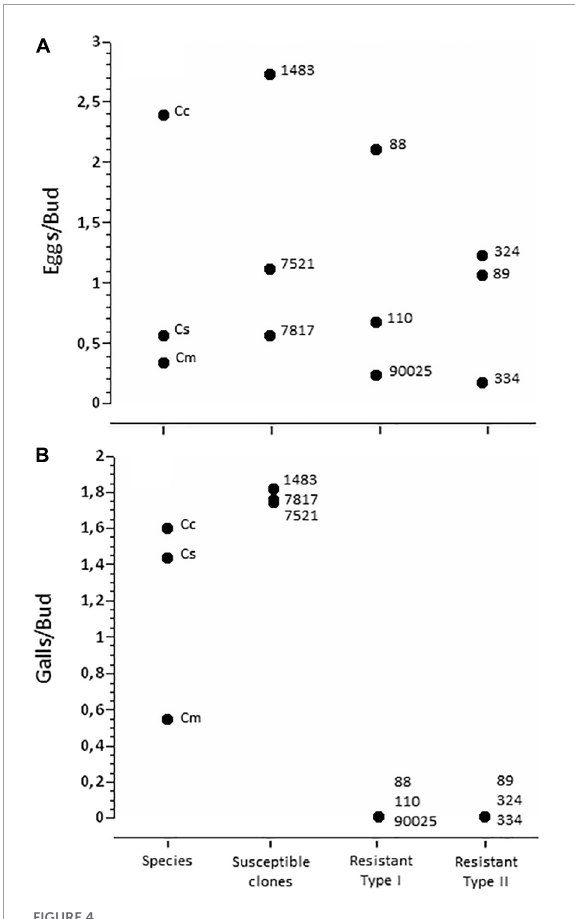
FIGURE4 (A) Number of eggs per bud in the study trees. Each point represents one species or hybrid, each represented by 6 dissected buds from each of 3 trees. (B) Number of galls per bud in the study trees. Each point represents one species or hybrid, each represented by 2–8 shoots within each of 3–7 trees. Numbers show the hybrid name; Cc, Castanea crenata ; Cm, C. mollissima; Cs, C. sativa